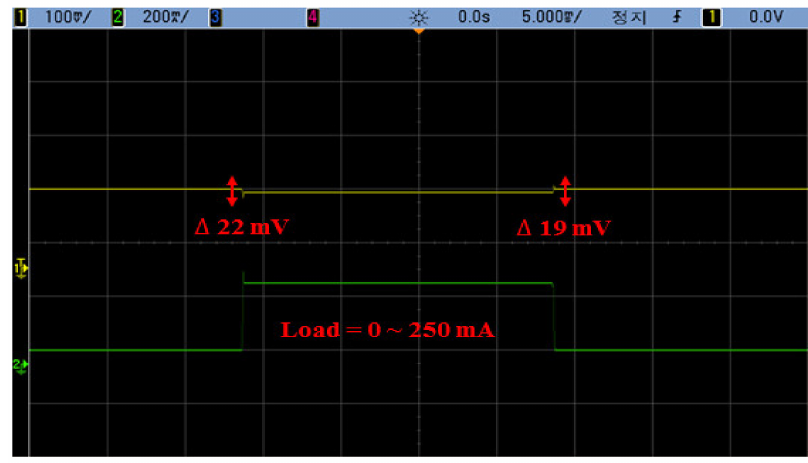
Figure 12. Load transient of the proposed LDO regulator (Load = 250 mA).